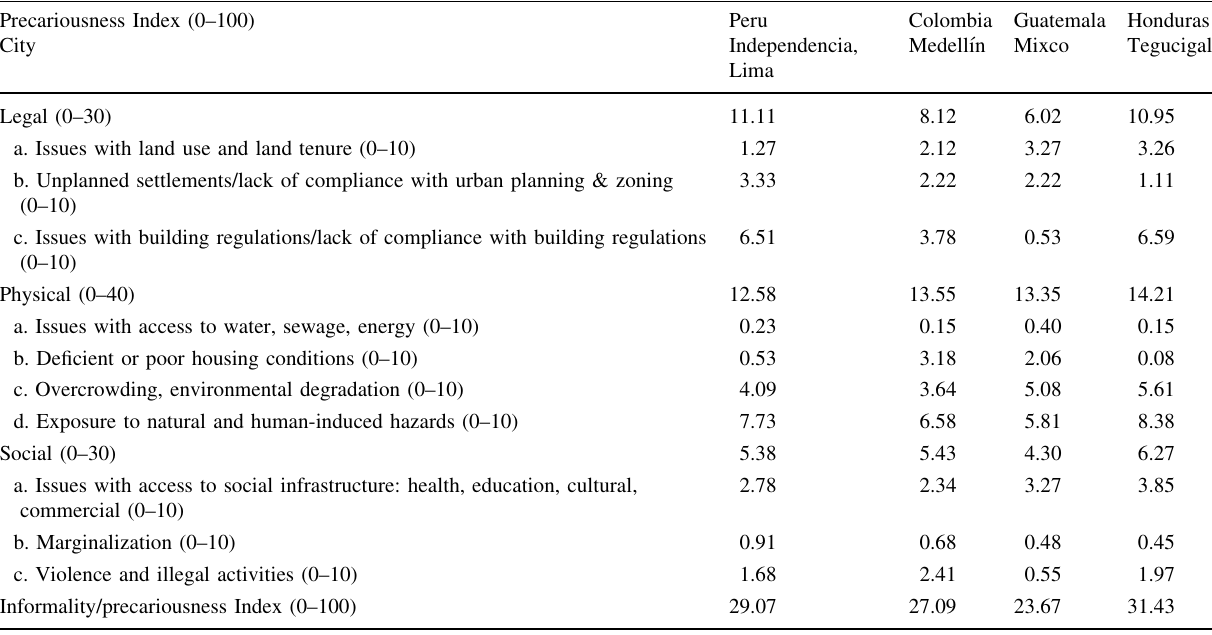
Table 2 Precariousness index of select communities with NA-DRR projects in Latin America. Source : Sarmiento et al. (2018) Precariousness Index